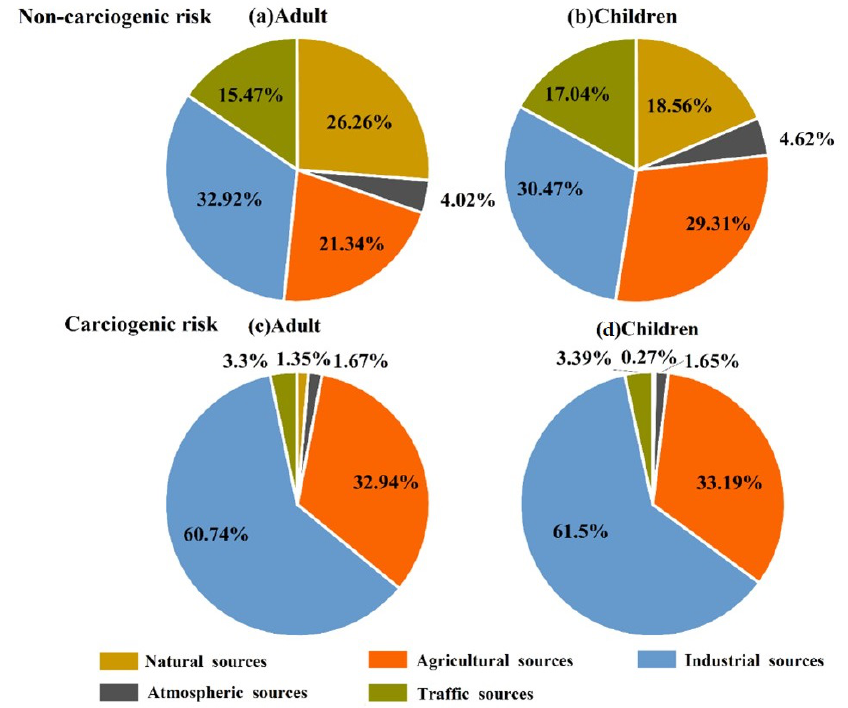
Figure 5. Contribution percentage of noncarcinogenic risks ( a , b ) and carcinogenic risks ( c , d ) from different